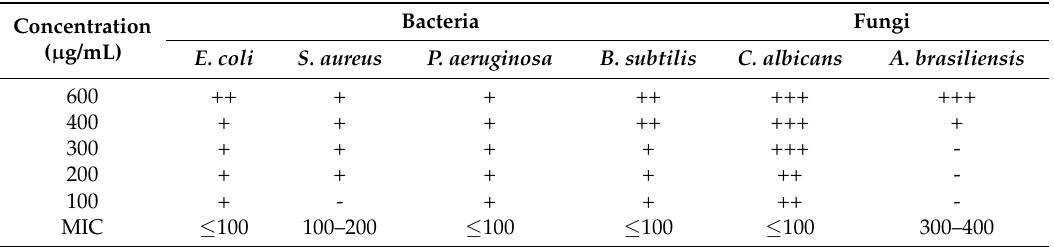
Table 4. Minimum inhibitory concentration (MIC) values of compound 5e